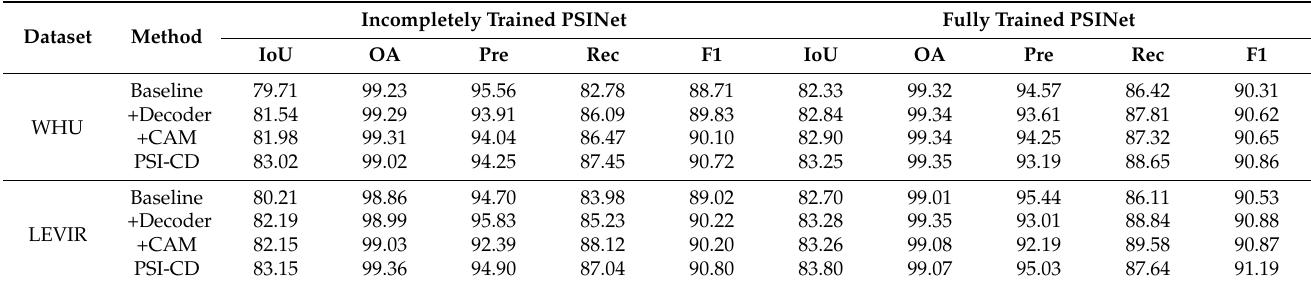
Table 5. Results of the ablation study for the WHU and LEVIR datasets (unit: %). Dataset